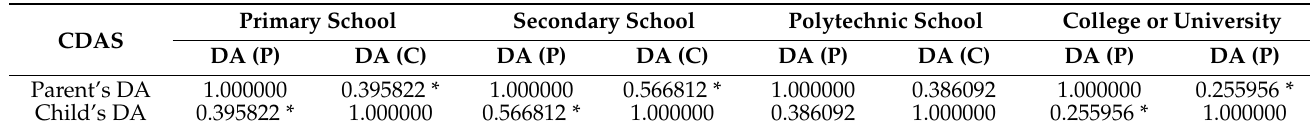
Table 3. Correlation between dental anxiety of parents and their children depending on the level of education the child is currently attending; Spearman rank correlation (marked correlations are significant at p < 0.01).